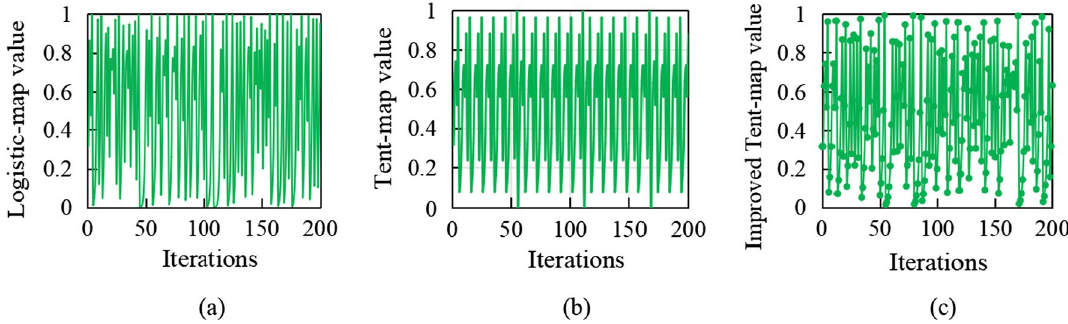
Fig. 1 Examples of logistic chaotic map, tent chaotic map, and the improved tent chaotic map